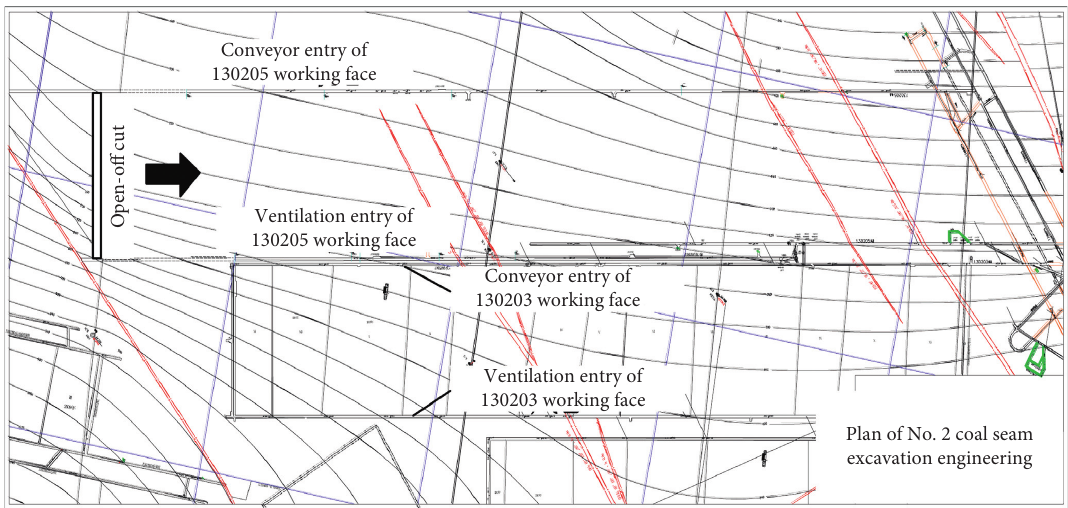
Figure 1: Relationship between the movement of the surrounding rock of the roadway and the abutment pressure distribution.